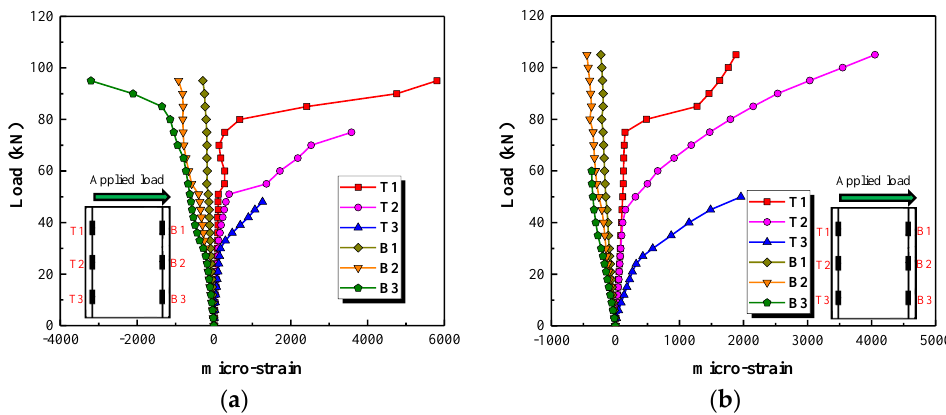
Figure 16. Strain in the longitudinal reinforcement. ( a ) Test specimen G1; ( b ) Test specimen S1.